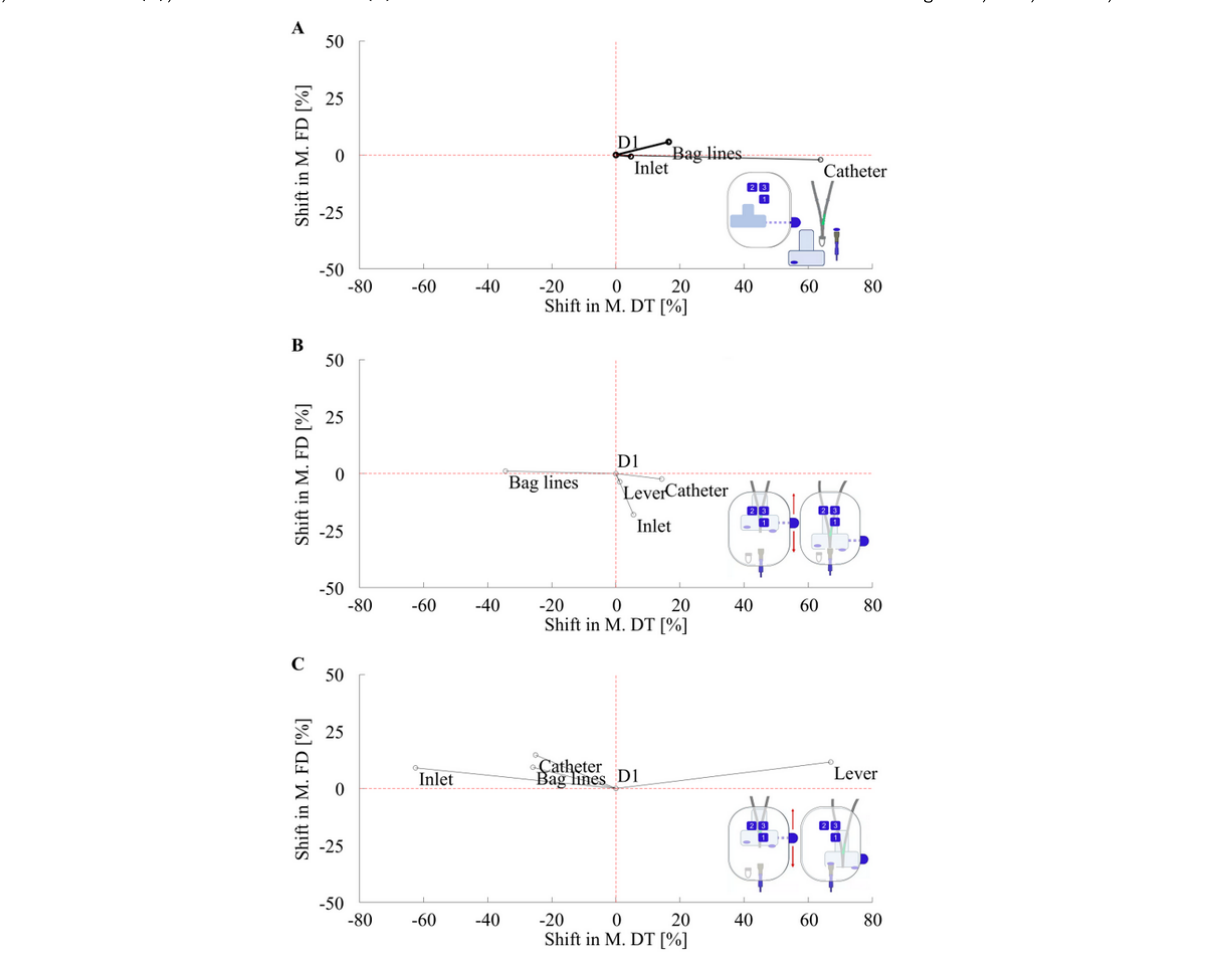
Figure 6. Shifts from D1 (in the coordinate origin) to D2 in terms of mean fixation duration (ordinate) and mean dwell time (abscissa) for task 1